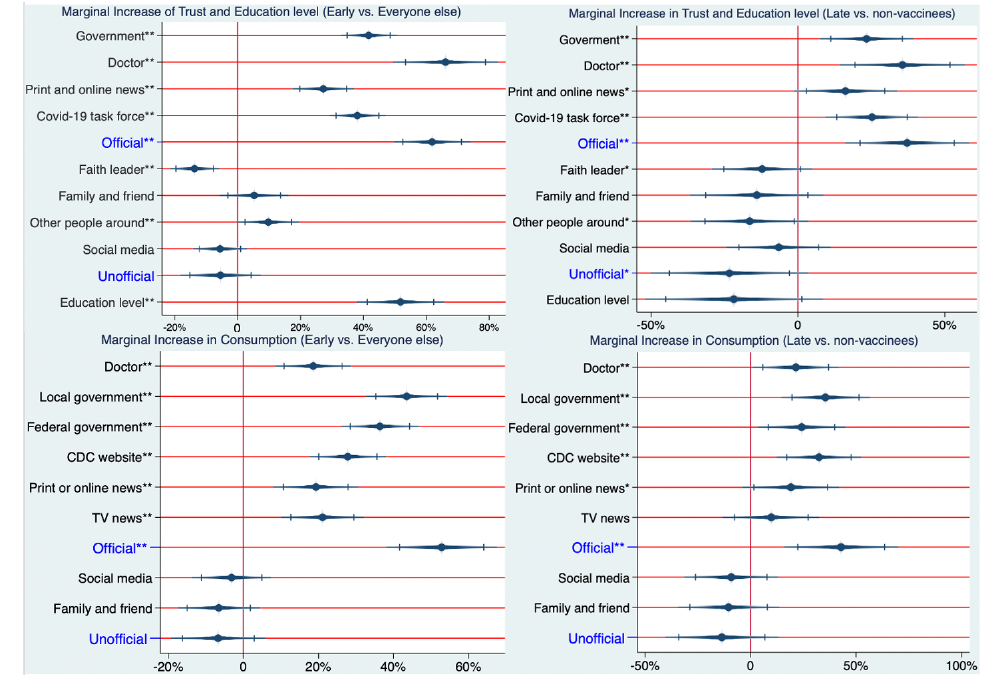
Figure 1. Regression results outlying the impacts of education, trust, and consumption variables on vaccination uptake. For this analysis, the impact of each variable is shown independently of the others. The values and the intervals in the graphs indicate the probability increase/decrease of being an early vaccinee or a late vaccinee, based on education, trust, and consumption variables, surrounded by 95% confidence intervals of those probabilities. Statistical significance (at * p < 0.05 and ** p < 0.01) is shown for each variable on trust in and consumption of various information